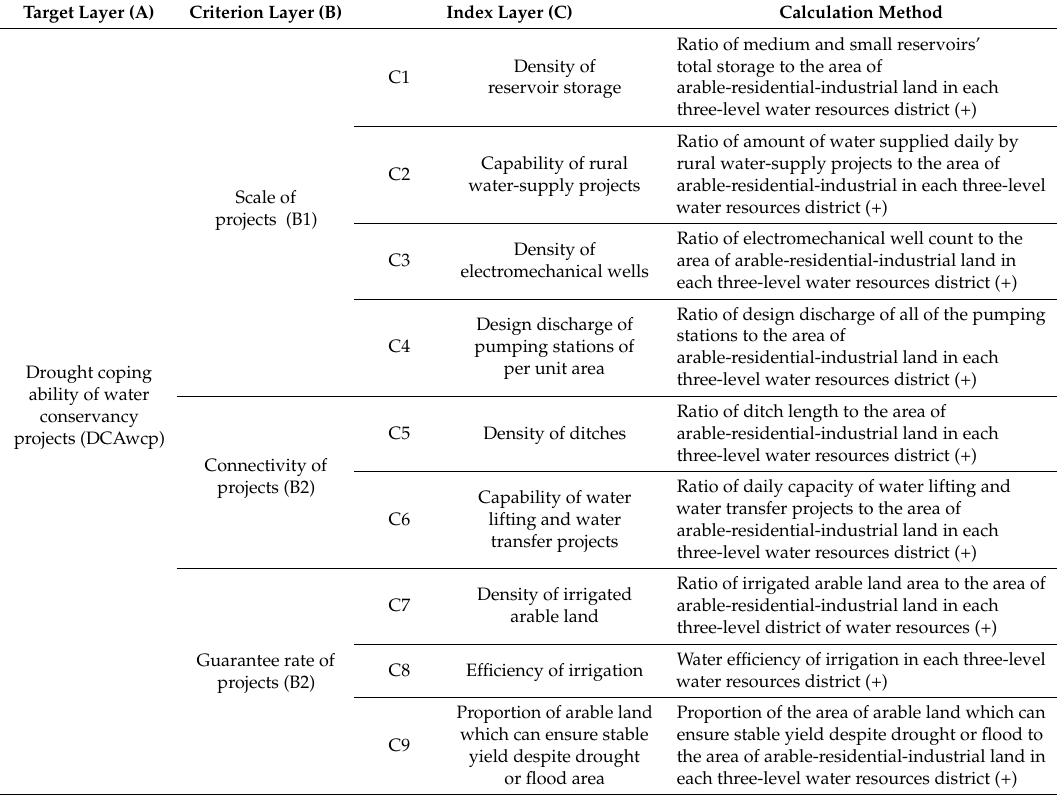
Table 2. Drought coping ability of water conservancy projects (DCAwcp) assessment